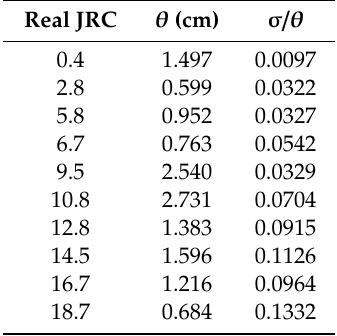
Table 2. The values of the spatial correlation length θ associated with each model function ρ ( ∆ x). Real JRC